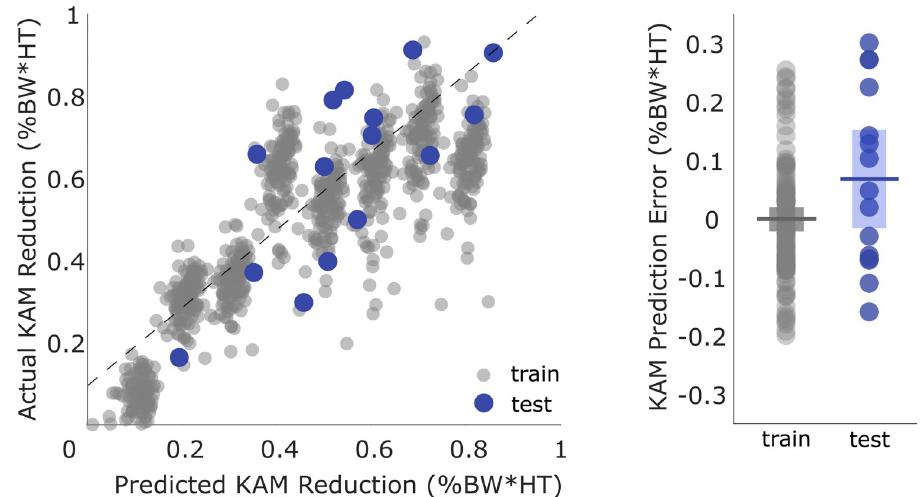
Fig 7. Validation of the predictive model (Carnegie Mellon dataset). An independent dataset of toe-in gait from 15 subjects was used to evaluate the predictive model, which achieved an MAE of 0.134%BW � HT ( ± 0.0932%BW � HT). The line of best fit (dashed line) has an R 2 of 0.55. The mean signed error of the model was not significantly different between the Carnegie Mellon University test data and the synthetic training or synthetic testing